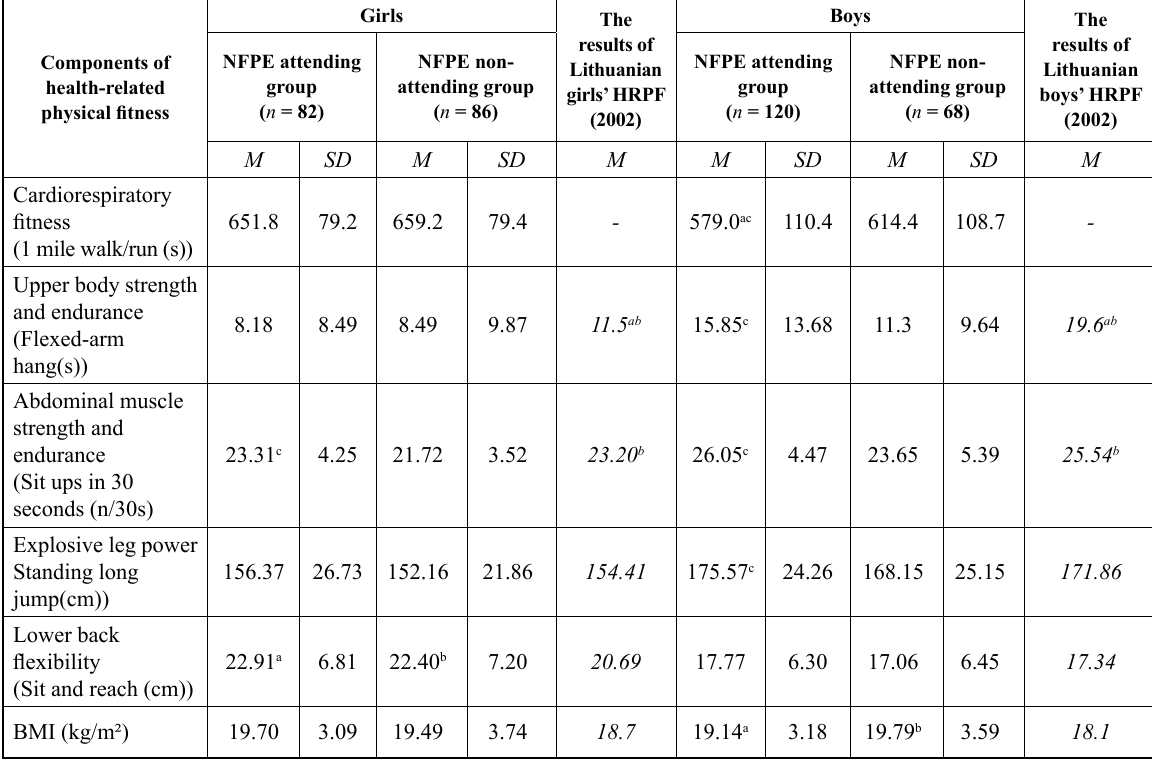
Table 2. Health-related physical fitness (HRPF) results (mean, standard deviation)